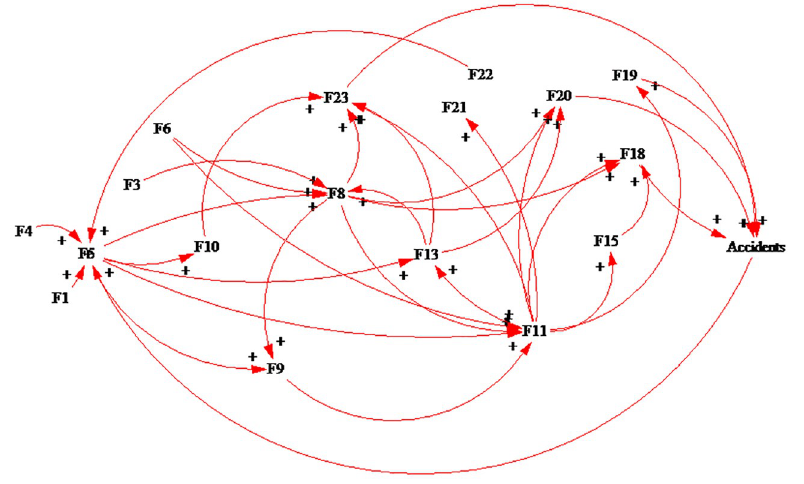
Fig 3. The interaction among the elements of HATCs in accidents.